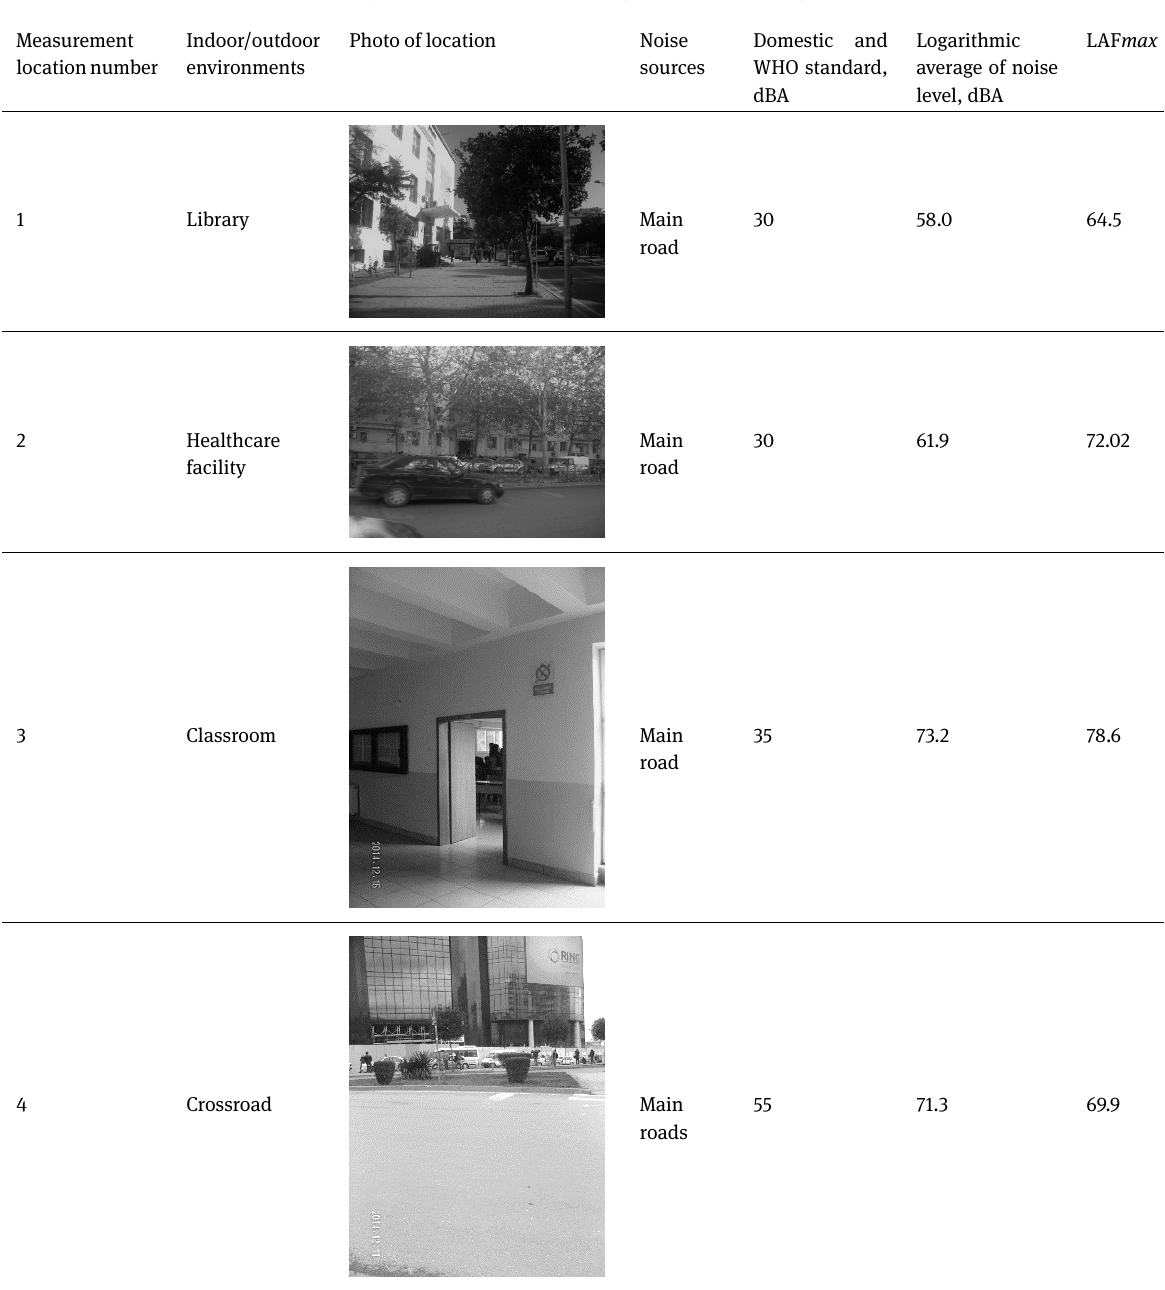
Table 1: Characteristics of locations, noise sources and levels in dBA. Logarithmic average values of noise level, LAF max , domestic stan- dards and those of World Health Organization (WHO) in dBA and outdoor noise sources. Measurement locations numbered from one to eight are in urban areas in Tirana. Photos for locations number one, two, seven and eight were taken in November 2016. Photos for loca- tions number three, four, five and six were captured in December 2014. All photos were taken by the